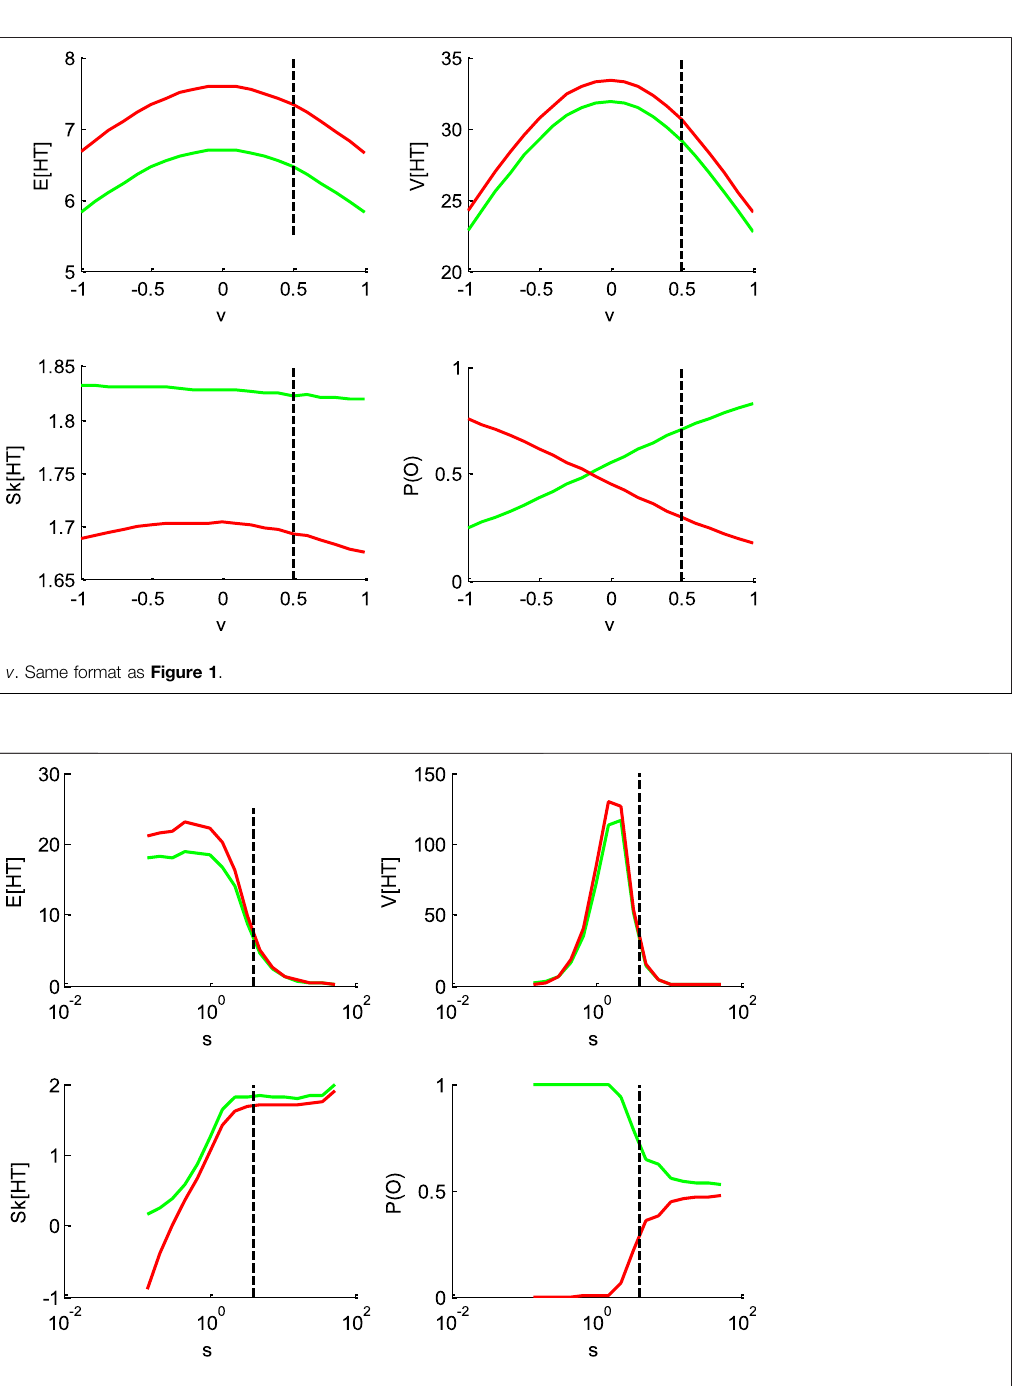
FIGURE 3 | Impact of the perturbation ’ standard deviation σ . Same format as Figure 1 (but the x -axis is now in